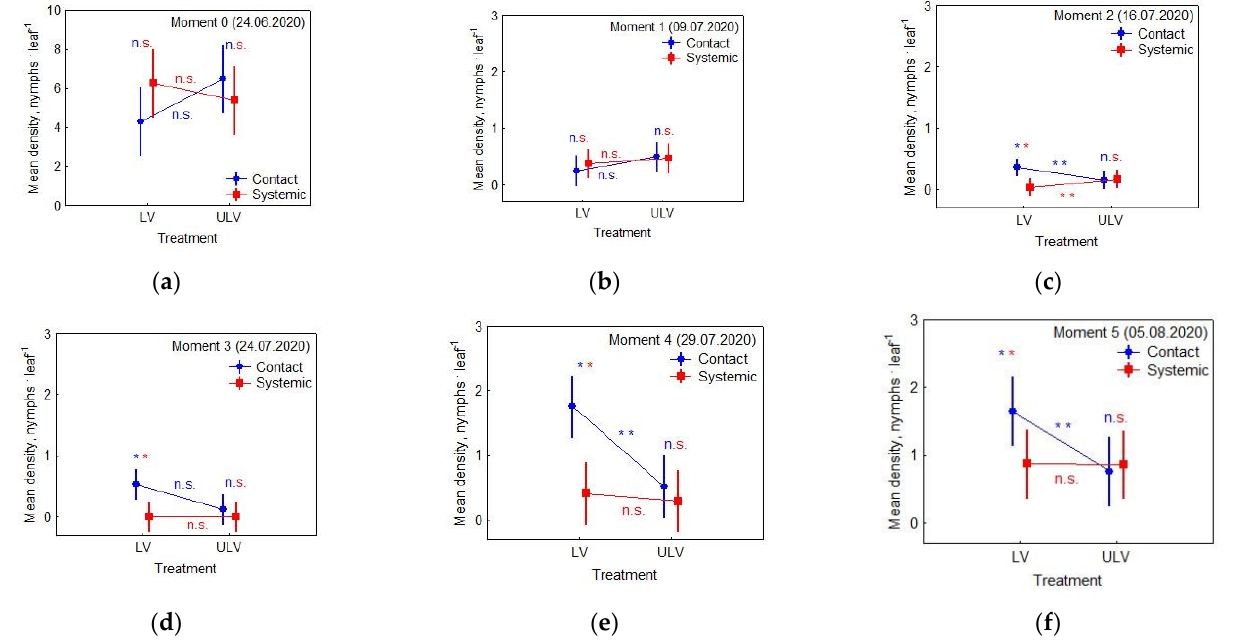
Figure 6. Effects of applied insecticide type (contact vs. systemic) and treatment volume (LV vs. ULV) on nymph density at each measurement time: ( a ) M0 (before spraying)-24 June 2020; ( b ) M1-09 July 2020; ( c ) M2-16 July 2020; ( d ) M3-24 July